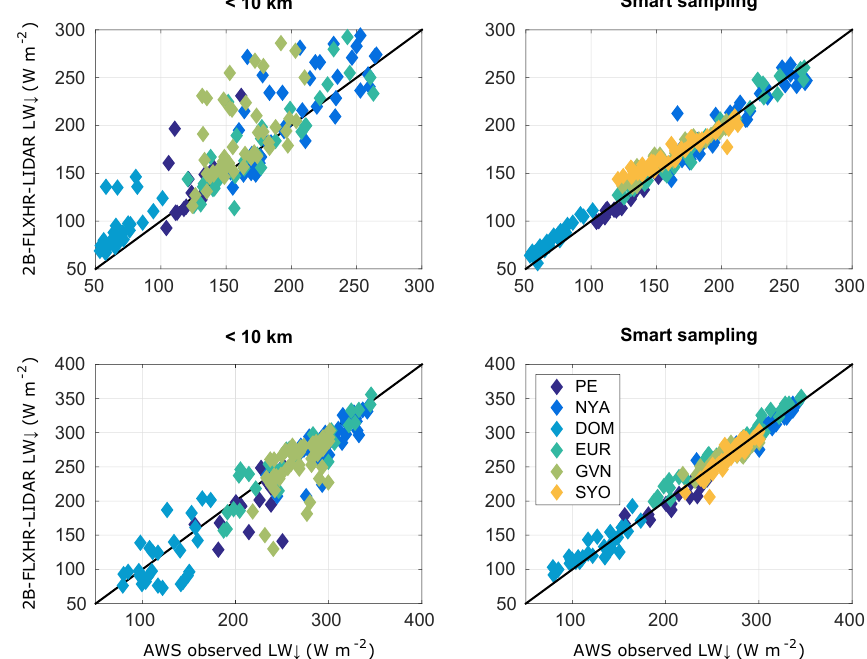
Figure 11. Monthly mean LW ↓ radiation comparison between 2B-FLXHR-LIDAR and AWS (2007–2010). Based on retrievals comprising of all satellite samples <10km from station, P10 ( r = 0 . 87) (upper left). Smart sampling approach, P10 ( r = 0 . 98) (upper right). Retrievals <10km from station, P90 ( r = 0 . 93) (lower left). Based on all satellite samples resulting from the smart sampling approach, P90 ( r = 0 . 99) (lower